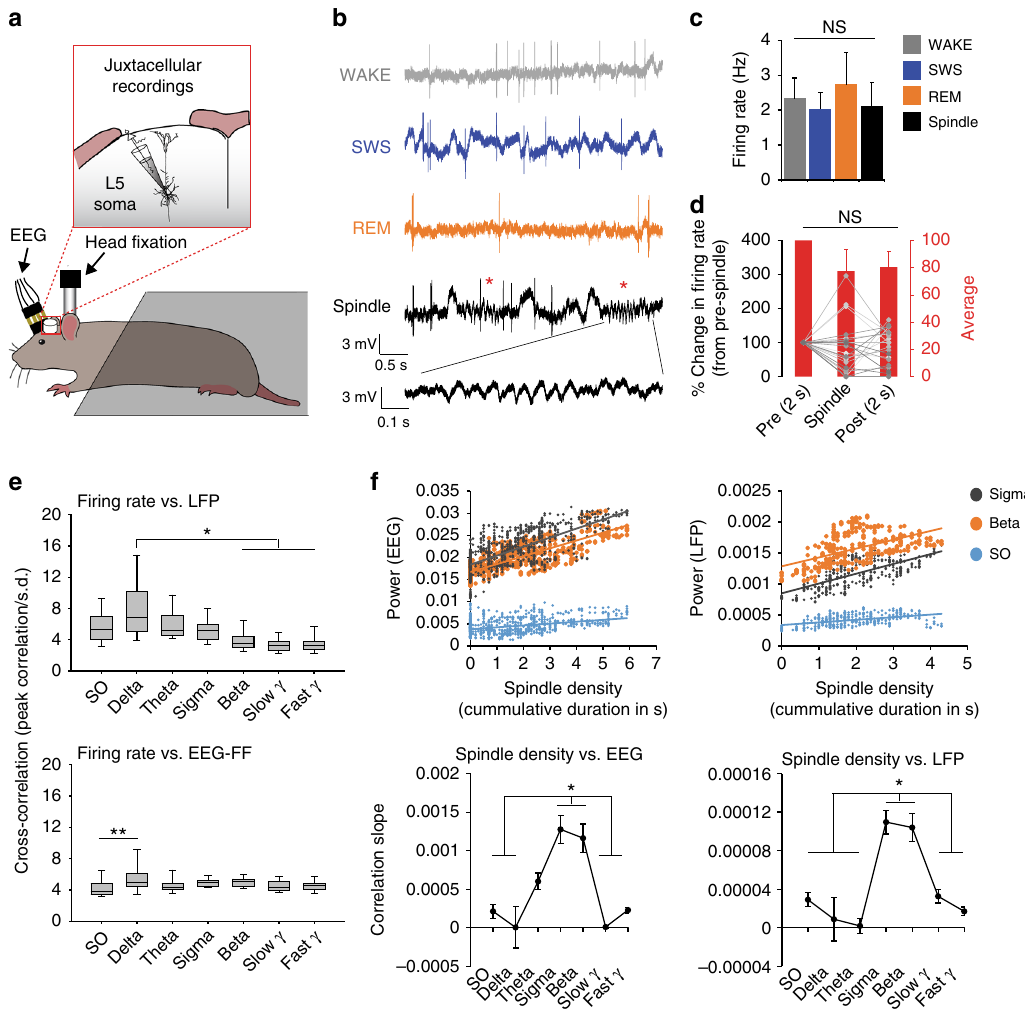
Fig. 7 Relationship between EEG, LFP and spiking activity of L5 cell bodies. a Schematic of combined juxtacellular and EEG recordings in head- fi xed rats. b Representative examples of local fi eld potential (LFP) traces and fi ring pattern of L5 pyramidal neurons during WAKE, SWS, REM sleep and isolated spindles during SWS ( red asterisks ). c Mean ( ± s.e.m.) fi ring rate across behavioural states and spindle events ( n = 23 cells/2 rats). d Peri-spindle change in fi ring rate (expressed as percentage of change from pre-spindle events) for each cell . Lines represent individual cells and red bars the average across all cells. e Average cross-correlation between fi ring rate and LFP/EEG frequency bands during SWS (expressed as the peak correlation within a ± 5s window/s.d. of the cross-correlation; see Methods). Firing rate shows a stronger correlation with delta oscillations in the LFP ( upper graph ; H = 55.2, P < 0.001 Kruskal – Wallis one-way ANOVA on ranks; * P < 0.05, Dunn ’ s test). A two-way ANOVA revealed a signi fi cant effect of EEG and frequency on fi ring rate (factor “ EEG ” : F = 12.49, factor “ frequency ” : F = 4.69, P < 0.001 for both factors). Post hoc comparisons showed a stronger correlation 1,224 1,224 between fi ring and delta oscillations only in the frontal EEG ( lower graph ; ** P < 0.01, Holm – Sidak test; see Supplementary Fig. 11 for parietal EEG results). f Sigma – beta oscillations re fl ect spindle density. ( Upper graphs ) Representative scatter plots showing correlation between spindle density (cumulative spindle duration within 10 s windows, see Methods) and EEG/LFP power for sigma, beta and SO for one recording (data points represent individual 10 s windows). ( Lower graphs ) Mean ( ± s.e.m.) correlation slope for all frequency bands for EEG and LFP recordings (EEG: H = 49.9, LFP: H = 51.8, P < 0.001 for both, Kruskal – Wallis one-way ANOVA on ranks; * P < 0.05, Dunn ’ s test; n = 17, see Methods for number justi fi